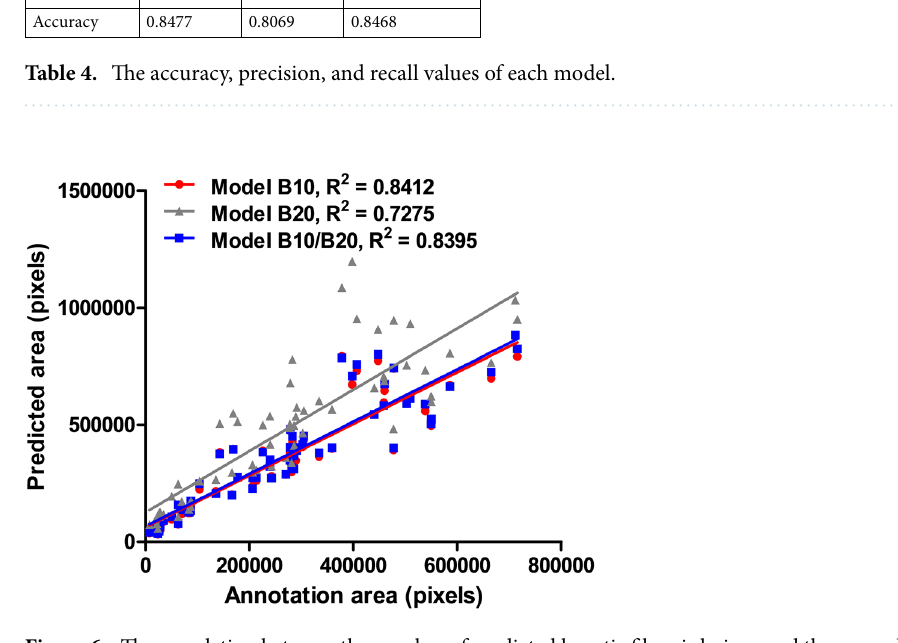
Figure 6. The correlation between the number of predicted hepatic fibrosis lesions and the ground truth annotation